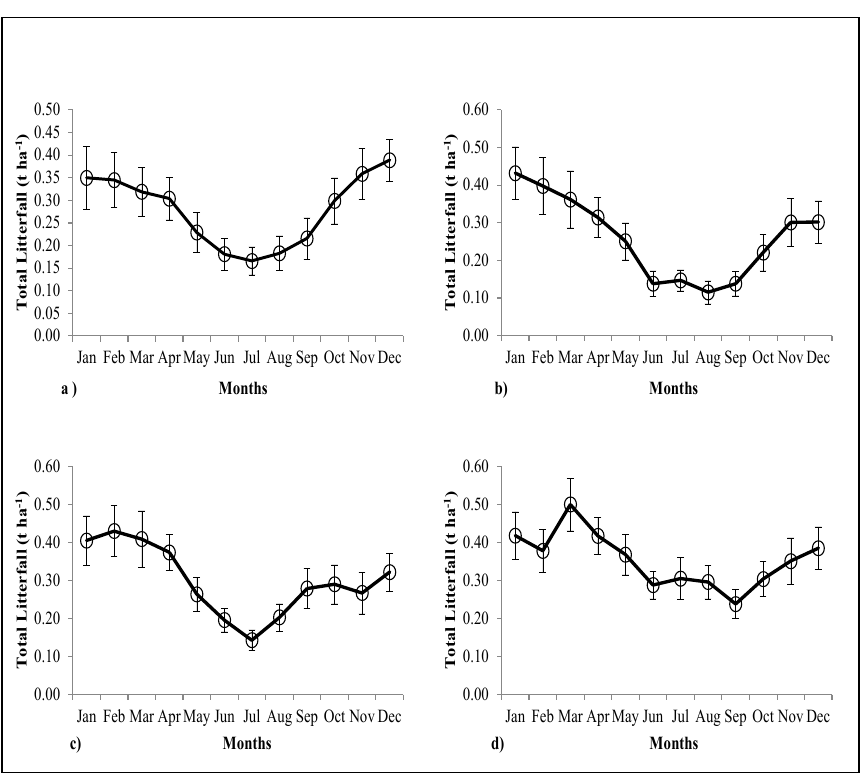
Figure 3. Total litterfall (Mg ha − 1 ) of D. latifolia plantation of different ages: ( a ) 4 years old; ( b ) 5 years old; ( c ) 6 years old; ( d ) 7 years old.